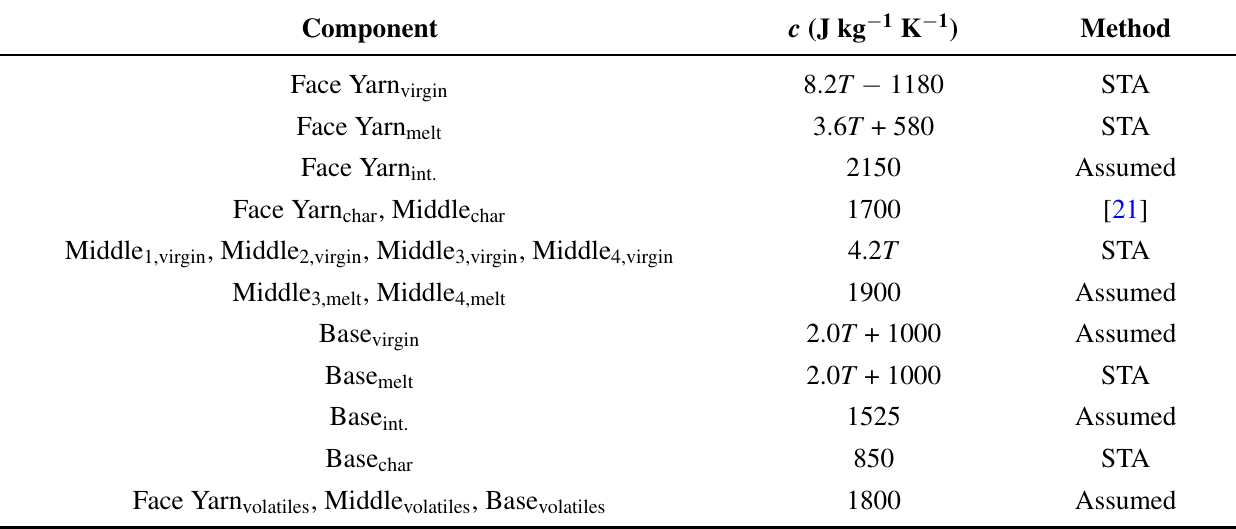
Table 2. Heat capacity values for each component in the carpet